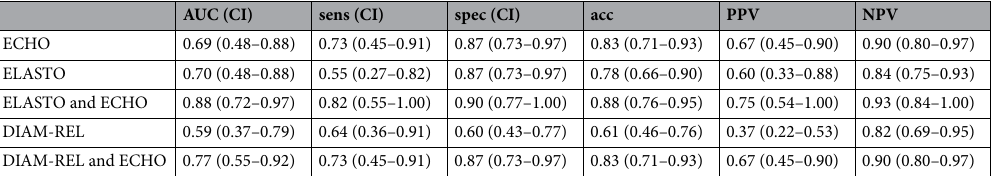
Table 4. Evaluation of selected classifiers of non-responding tumours (RMC ≥ 70%) after third NAC course. Evaluation parameters are given with the 95% confidence level (95% CL). Sens sensitivity, spec specificity, acc accuracy, PPV positive predictive value, NPV negative predictive value.